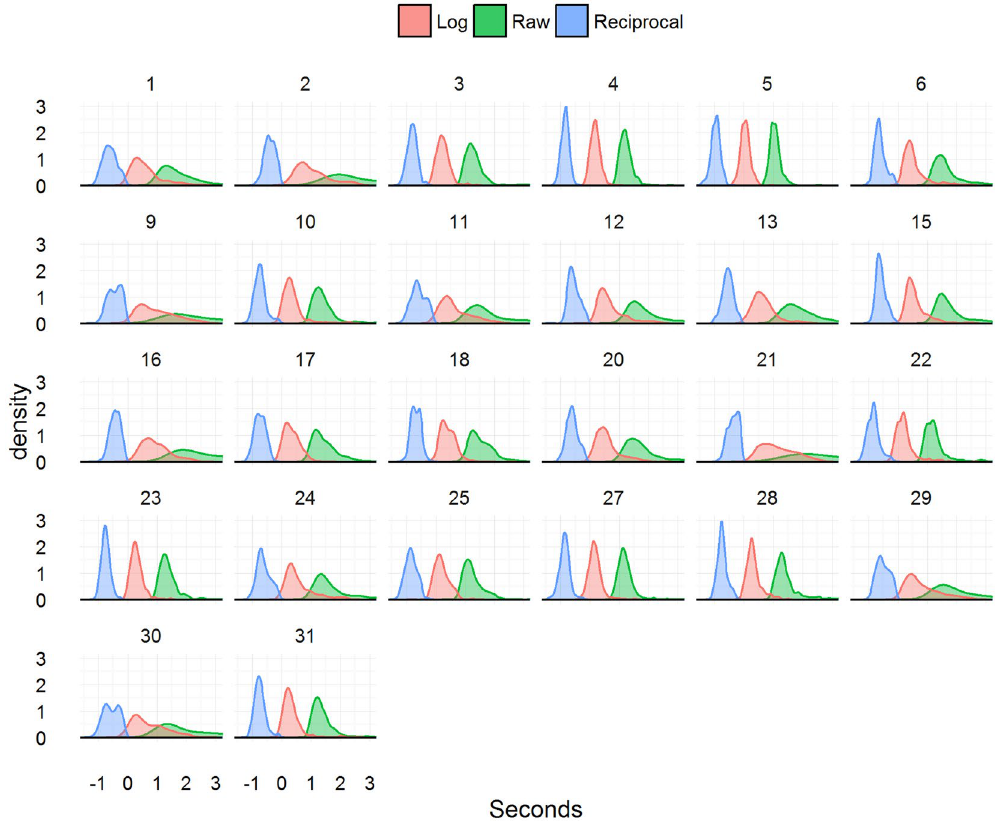
Figure 3. Reaction time density distributions by subject and transformation method. Note: the tapering right- hand tail of some distributions was snipped above 3 s to aid